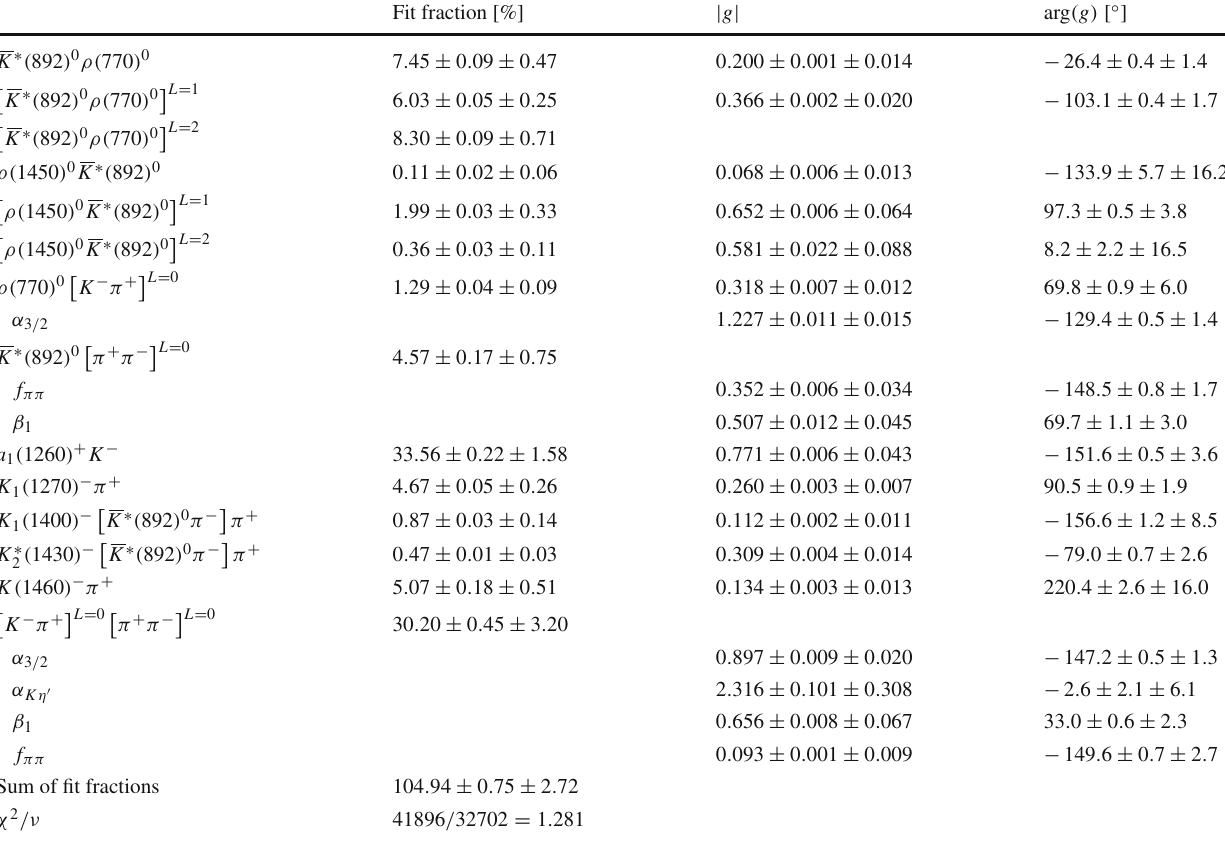
Table19 Tableoffitfractionsandcouplingparametersandotherquan- tities for the RS decay D 0 → K − π + π + π − , for a model excluding the decay chain K 1 ( 1270 ) − → ρ( 1450 ) 0 K − . Also given is the χ 2 per